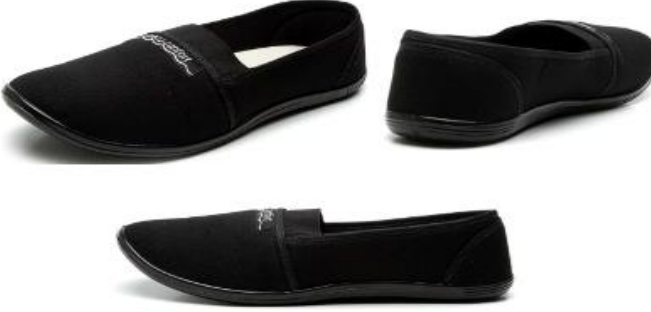
Figure 3. Minimalist flexible shoes worn for six months of intervention.